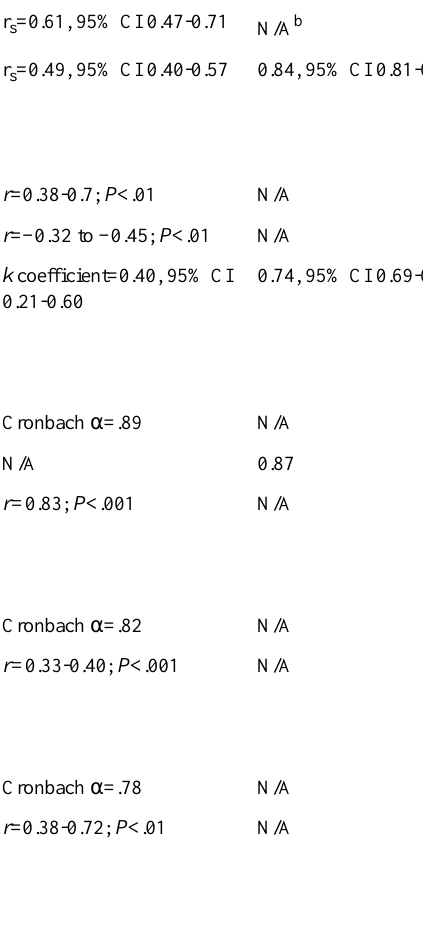
Table 2. Treatment effect outcomes, outcome measures, and psychometric properties. Change in accelerometer-measured PA a (ie, minutes of sedentary, light, and moderate-to-vigorous activity) ActiGraph model GT3X-BT accelerometer